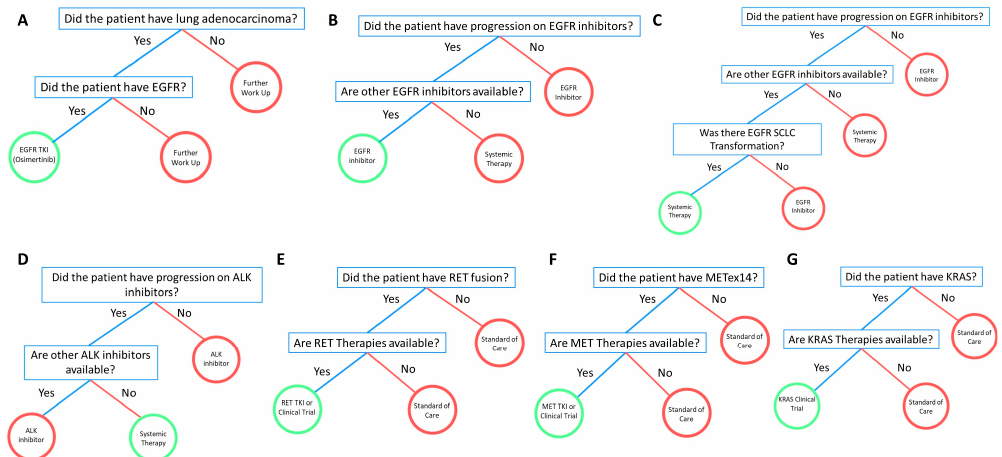
Figure 2. Fast-and-Frugal trees developed from community practice cases. ( A – C ) Representative fast-and-frugal trees for EGFR-mutated patient case scenarios. ( D ) Fast-and-frugal tree applicable to ALK mutated patient scenarios. ( E ) Fast-and-frugal tree for RET decision-making. ( F ) Fast-and-frugal tree for MET decision-making. ( G ) KRAS mutated fast-and-frugal decision-making